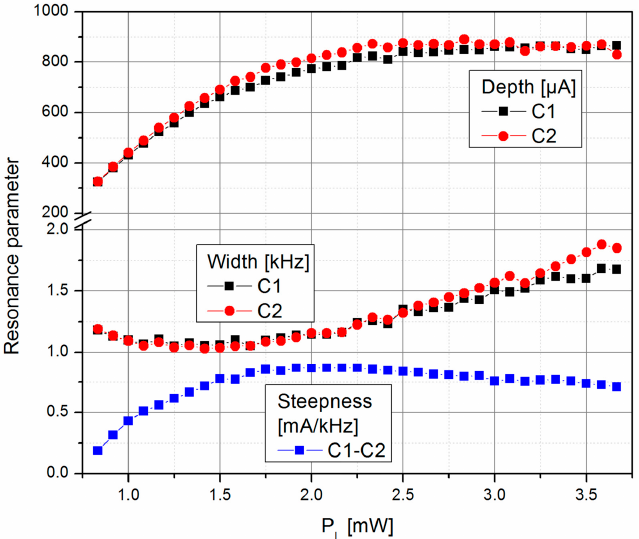
Figure 7. Dependence of the resonance width (half width at half maximum), determined by the relaxation rate Γ , and depth of the two individual cells and the resulting LSD-Mz signal steepness d I d /d f B1 on the laser pumping power P L .